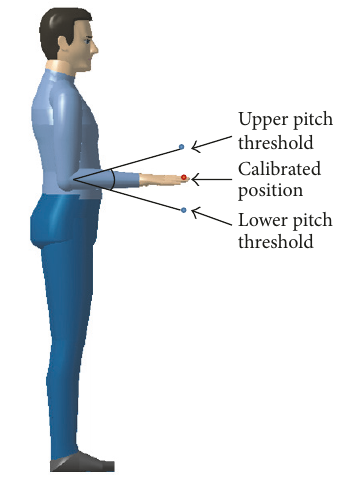
Figure 4: An illustration of calibrated hand position and trigger thresholds for pitch